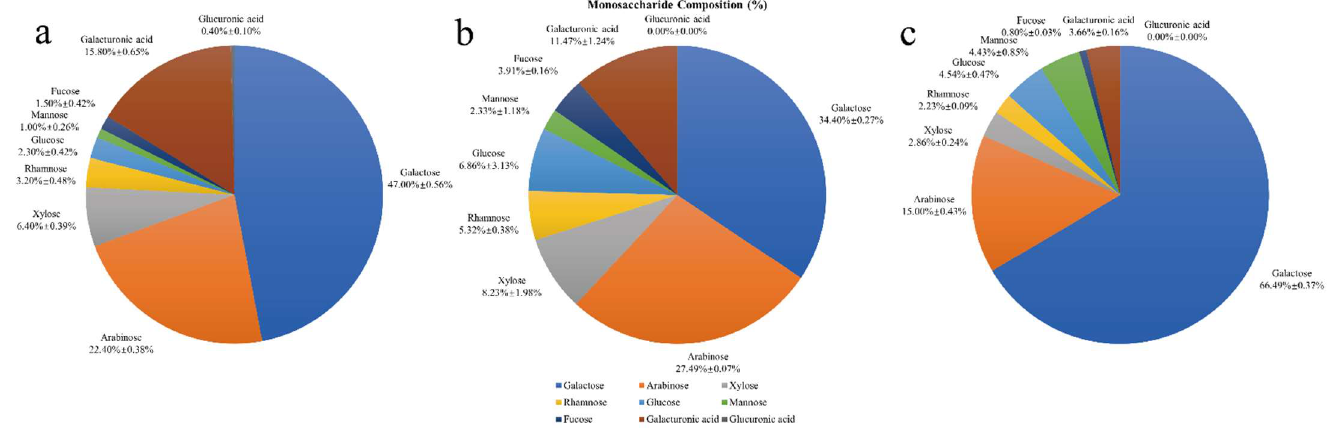
Figure 5. The monosaccharide composition of HPIDF, F-HPIDF, and hydrolysate. ( a : HPIDF; b : F-HPIDF; c : Hydrolysate).